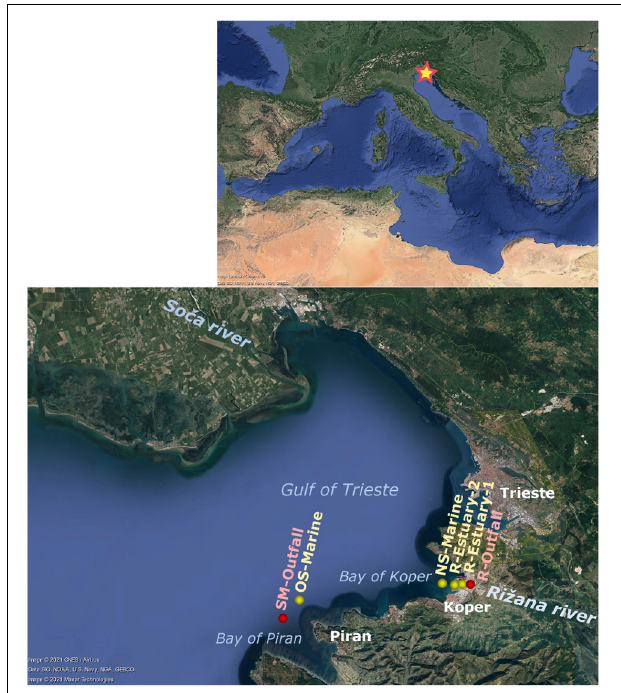
FIGURE 1 | Map of the Mediterranean Sea showing sampling stations in the Bay of Koper and the Bay of Piran (Gulf of Trieste, northern Adriatic Sea): submarine outfall (SM-Outfall), offshore marine (OS-Marine), nearshore marine (NS-Marine), Rižana estuary 2 (R-Estuary-2), Rižana estuary 1 (R-Estuary-1), Rižana outfall (R-Outfall). Study area is subject to anthropogenic pressures: wastewater inputs (SM-Outfall = submarine outfall of WWTP Piran, R-Outfall = outfall from WWTP Koper), urban areas (Trieste, Koper and Piran) and port of Koper (located in Bay of Koper). Study area is presented with Google Earth image (Google Earth Pro 7.3.4.8248: Image © 2021 CNES/Airbus; Data SIO, NOAA, U.S. Navy, NGA, GEBCO; Image © 2021 Maxar